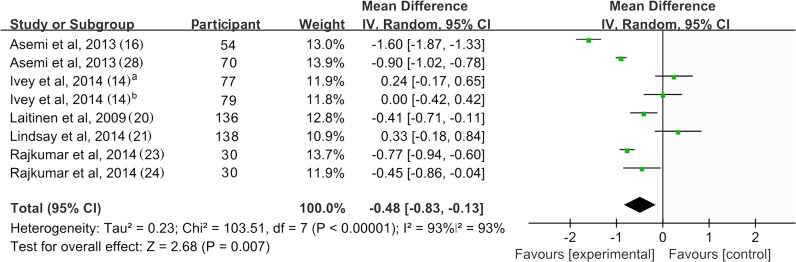
Forest plot of randomized controlled trials comparing the effect of probiotics on HOMA-IR with placebo/comparator.Weighted mean differences (95% CIs) for HOMA-IR are shown. Pooled estimates (diamonds) calculated by the random effects method. IV, inverse variance.